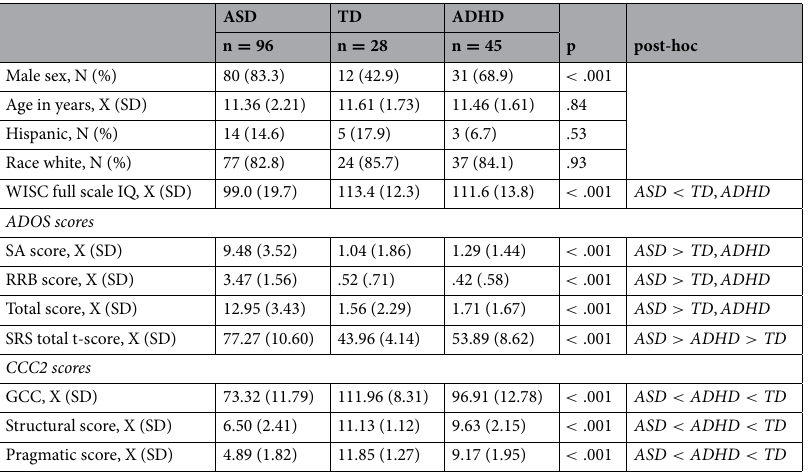
Table 1. Sample characteristics. Post-hoc Tukey, p < .05 . SD: standard deviation. Full ranges of clinical measures can be found in Supplementary Table